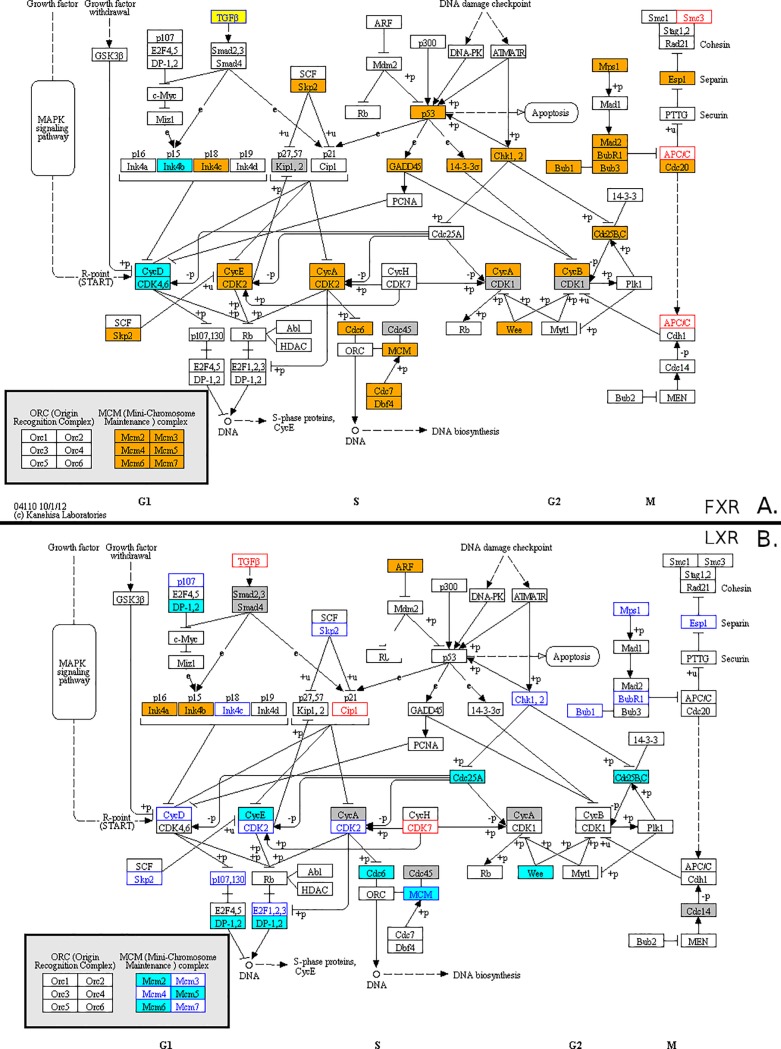
Visualisation of the effects of FXR-L and LXR-L on the KEGG cell cycle pathway map.Genes found in the leading edge of the cell cycle pathway at 24h after FXR-L (panel A) and LXR-L (panel B) treatments are highlighted. Boxes with a blue (resp. orange) background denote down-regulated (resp. up-regulated) genes (|log fold change| > 1.2). White boxes with blue (resp. red) text denote smaller down-regulations (resp. up-regulations). Grey boxes denote genes which are not differentially expressed despite appearing in the leading edge. The yellow TGFβ box in panel A corresponds to the TGFβ1, TGFβ2 and TGFβ3 genes that are regulated in opposite directions.